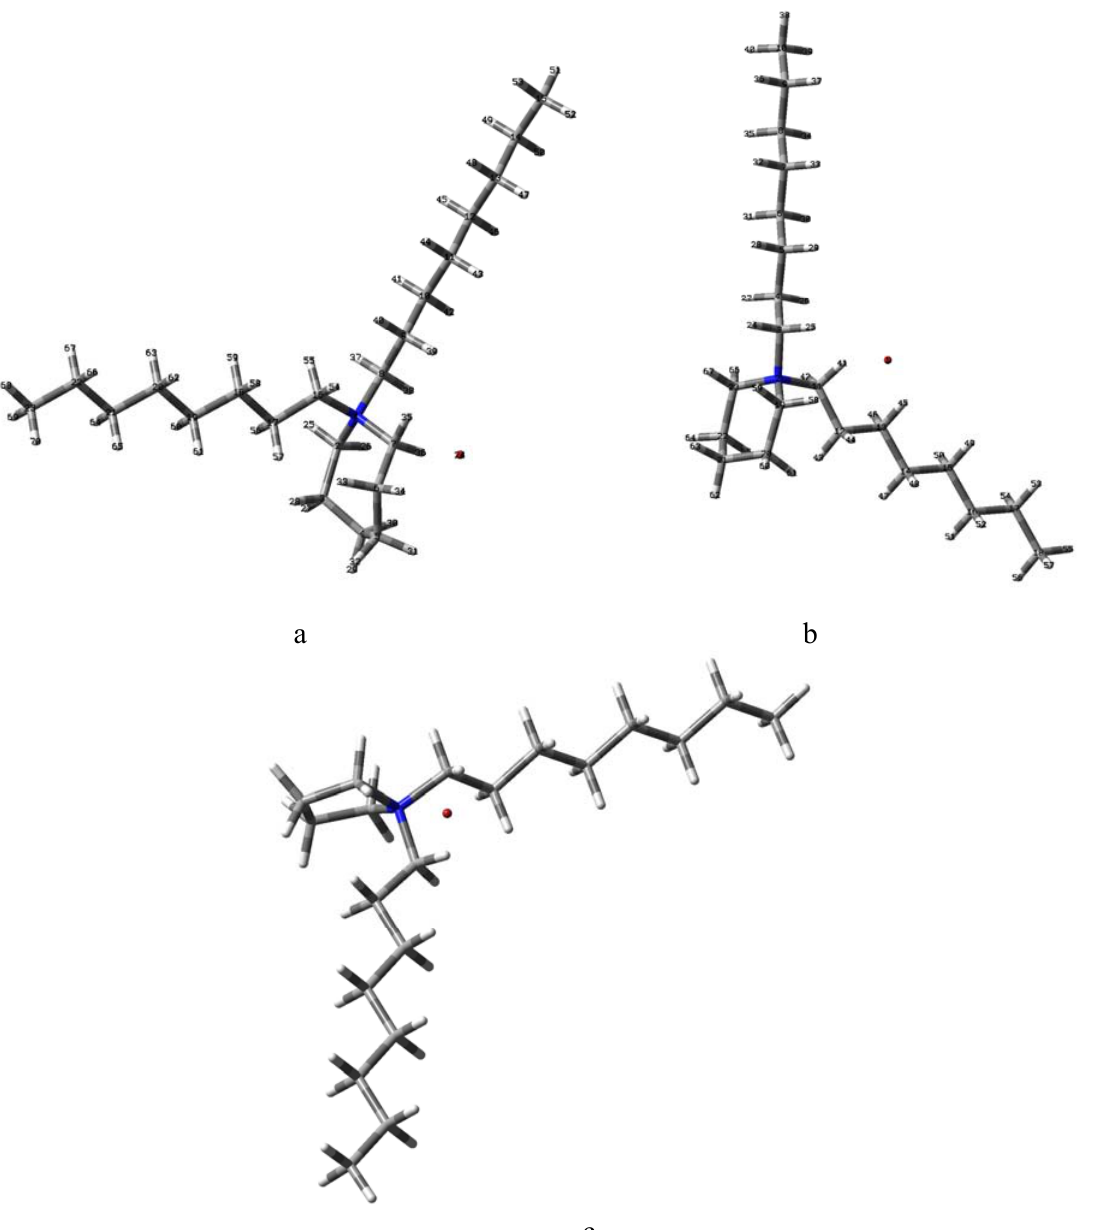
Figure 2. Structures of (a) N,N -dioctylazepanium ( 1 ), (b) N,N -dioctylpiperidinium ( 2 ), (c) N,N- diocylpyrrolidinium ( 3 ) bromides optimized by the B3LYP/6-31G(d,p)